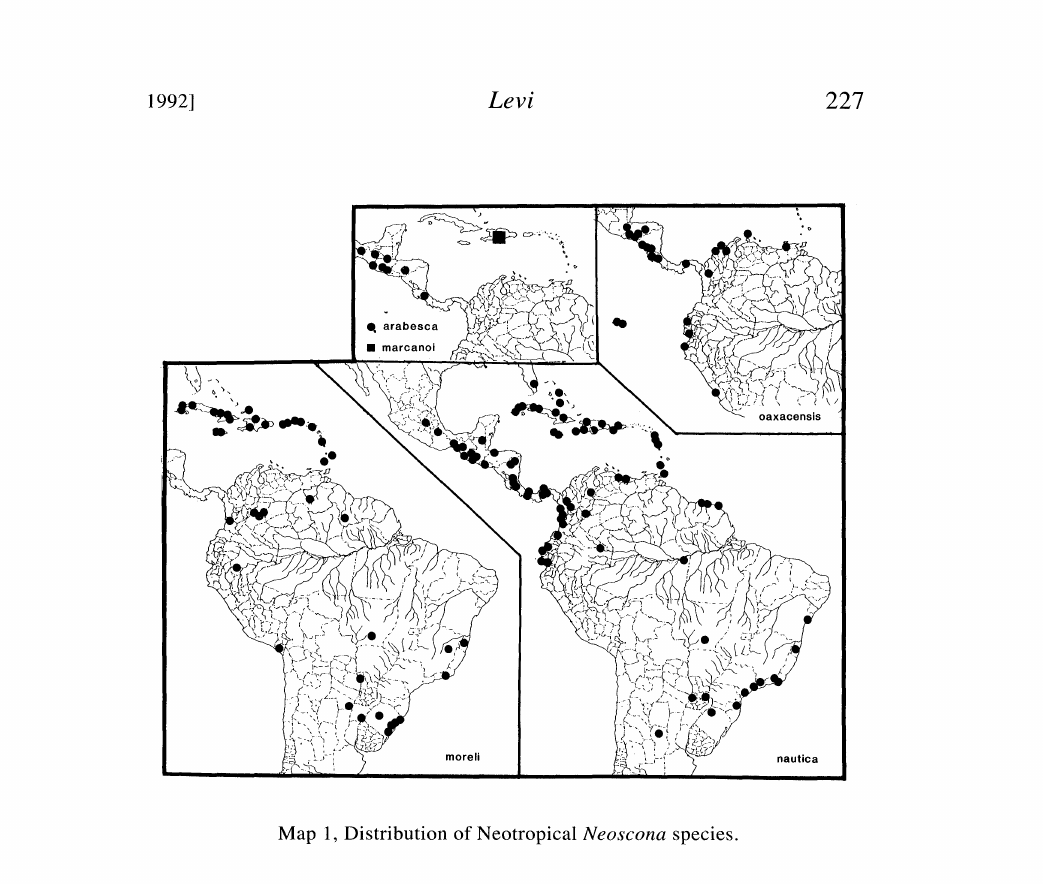
mm. Carapace 5.1 mm long, 4.0 wide, behind lateral eyes 1.8 wide. First femur 5.7 mm, patella and tibia 6.9, metatarsus 5.7, tarsus 1.4. Second patella and tibia 5.9 mm, third 3.5, fourth 5.8. Male paratype: Color as in female, but venter of abdomen gray with white spots touching. Posterior median eyes 0.7 diameter of anterior medians, laterals 0.7 diameter. Anterior median eyes their diameter apart, 1.3 diameters from laterals. Posterior median eyes their diameter apart, 2.3 diameters from laterals. Height of clypeus 0.6 diameter of anterior median eye. Endite with tooth, palpal femur with tooth. First coxa with hook, fourth with a tubercle on posterior face. Second tibia thicker than first, swollen, with prolat- eral macrosetae (Fig. 9). Abdomen oval. Total length 7.0 mm. Carapace 3.6 mm long, 2.7 wide, behind lateral eyes 1.1 wide. First femur 4.8 mm, patella and tibia 6.3, metatarsus 5.7, tarsus 1.3. Second patella and tibia 4.3 mm, third 2.6, fourth